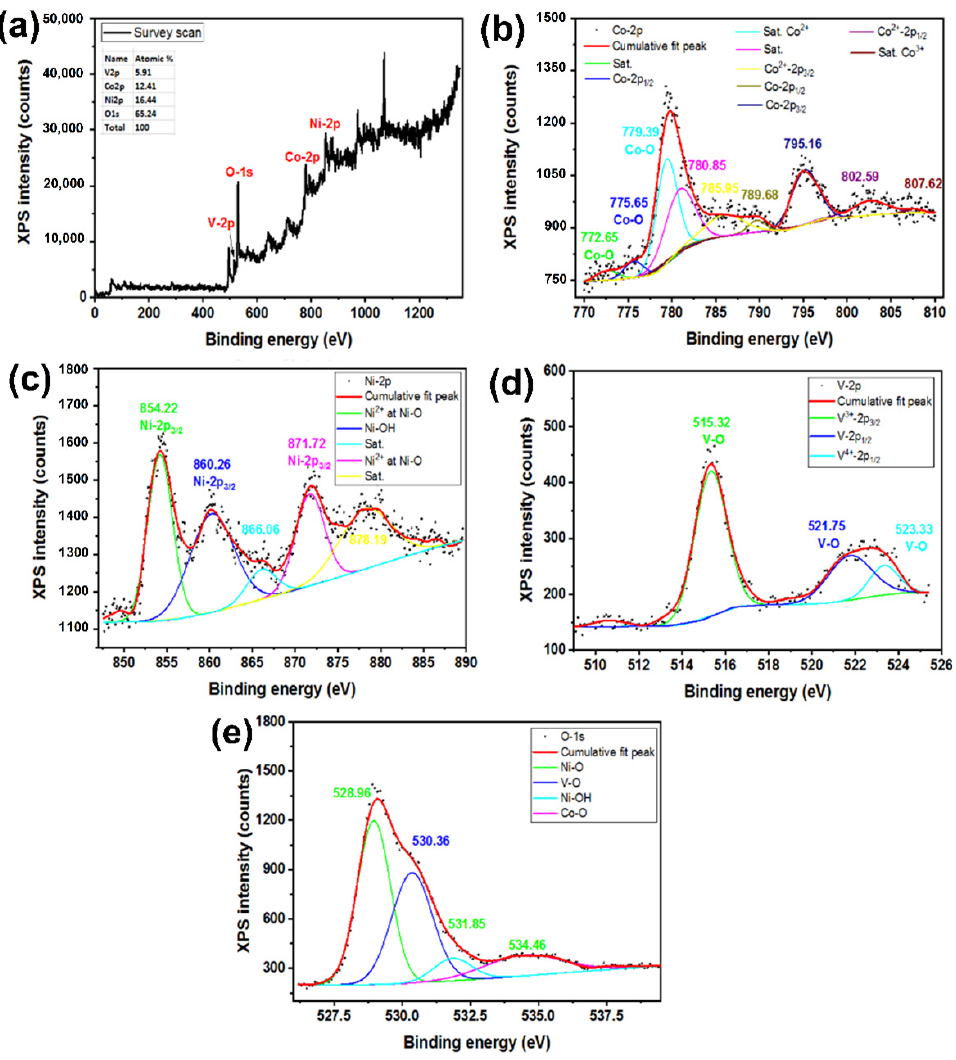
Figure 6. XPS of a Co x NiV y O z layer coated on a Ni foam substrate, ( a ) survey scan, ( b ) Co-2 p , ( c ) Ni- 2 p , and ( d ) V-2 p , and ( e ) O-1 s.